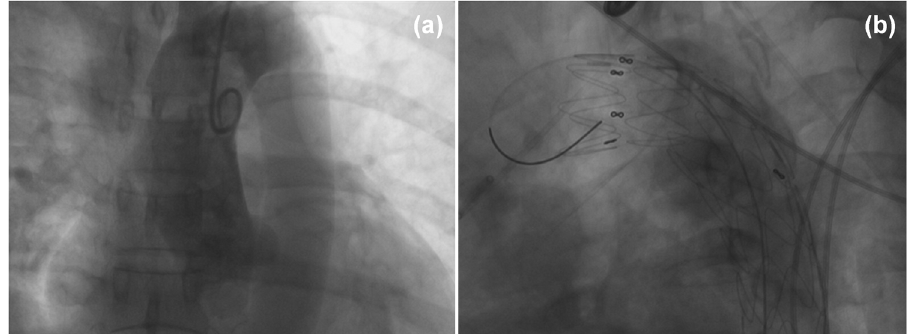
Figure 2: Digital subtraction angiography image showing mild stenosis in the thoracic aortic lesion without an obvious intimal fl ap ( a ) and the implanted stent ( b )